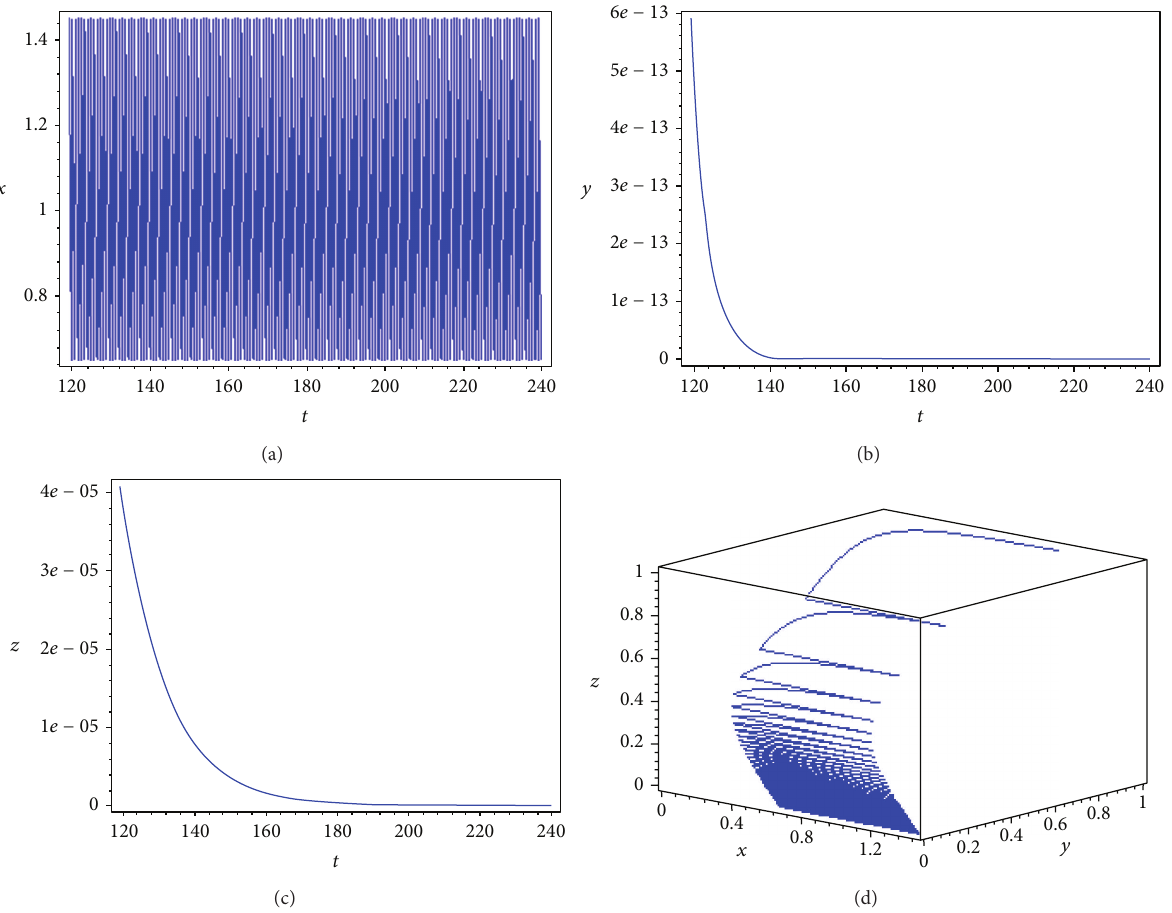
Figure 1: Time series of the system (2) with pulse. 𝑎 1 = 0.2 , 𝑎 2 = 0.2 , 𝑚 1 = 1.3 , 𝑞 = 0.16 , and 𝑇 = 0.5